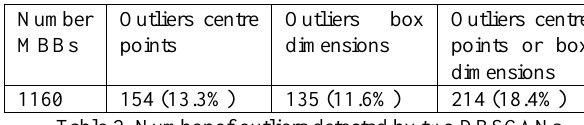
Main data view (A): Shows a circular area of the 3D point cloud around the coarse positon of the vehicle and the MBB. The point cloud can be rotated and zoomed by mouse controls. The MBB can be moved and scaled in x , y and z . Three sub-views (B): Show the 3D point cloud and the MBB as 2D projections in x -, y - and z -direction. It is possible to change the width and the height of the two- dimesional projection of the MBB.